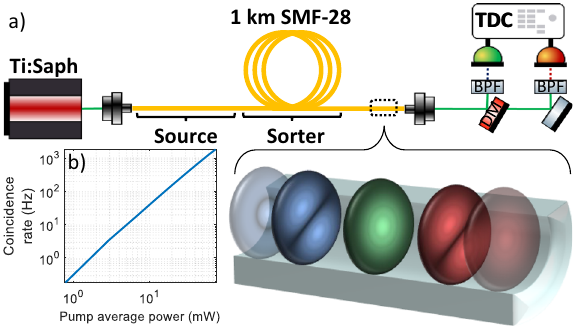
Fig. 1 An all- fi ber multimode source and mode sorter for photon pairs correlated in the fi ber modes. a Ultrashort pulses of 140fs ( λ pump = 695 nm) are coupled into a 1-km-long fi ber. Pump photons are spontaneously annihilated and pairs of signal and idler photons are generated at two different spectral channels ( λ s = 542 nm, λ i = 970 nm). At these wavelengths, the fi ber (SMF-28) supports a few modes, where the modal distribution of the photon pairs is determined by the phase-matching condition of the fi ber. After the fi rst few tens of centimeters, the temporal spread of the pump pulse prevents SFWM. In the next 1-km of the fi ber, the different modes are separated due to modal dispersion (inset). Higher spatial modes arrive after lower spatial modes, and shorter wavelengths arrive after longer wavelengths. At the output of the fi ber, the signal and idler photons are spectrally separated by a dichroic mirror (DM), fi ltered by a bandpass fi lter (BPF), and their arrival times are registered using two single-photon detectors and a time-to-digital converter (TDC). An electronic delay of 70 ns is introduced to the idler detector to compensate for the chromatic delay between the signal and idler photons. b Experimentally measured coincidence rate as a function of the pump average power for a 20-cm-long fi ber, exhibiting a quadratic scaling.